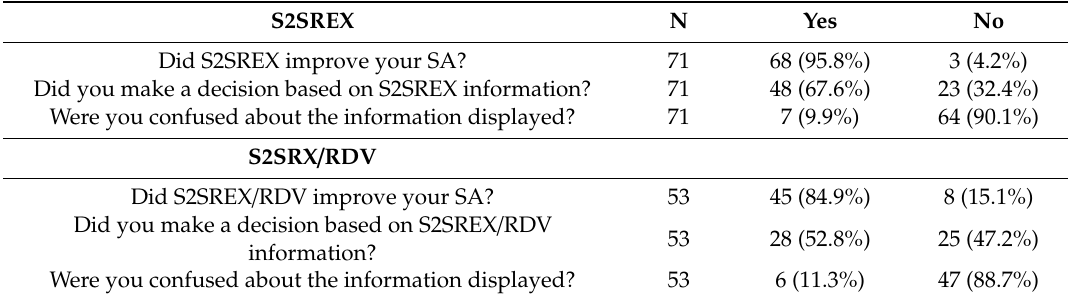
Table 2. Frequency distribution of S2SREX and S2SREX / RDV for situation awareness (SA), decision making, and clarity of the information.